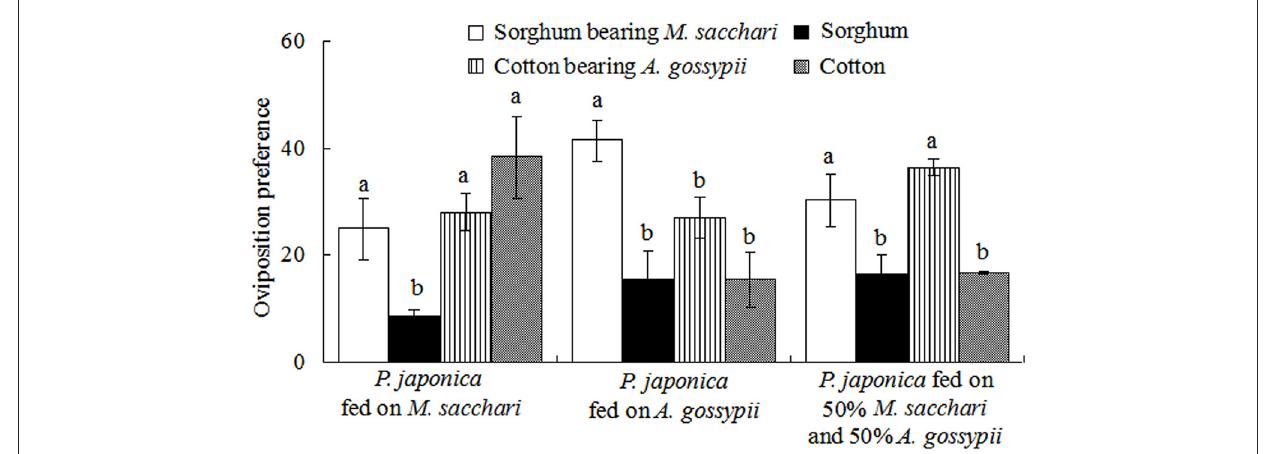
FIGURE5 Effect of host plant on the oviposition preference of adult Propylaea japonica originally fed different aphid-based diets ( M. sacchari , A. gossypii , and 50% M. sacchari + 50% A. gossypii ). Different lowercase letters indicate significant differences between the type of host plant treatment within a P. japonica treatment ( X 2 test: P <